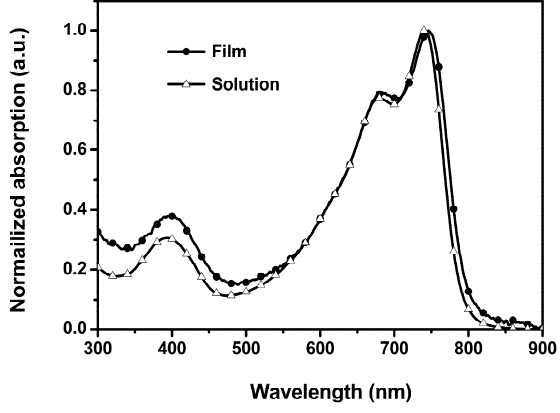
Figure 1. UV–vis absorption spectra of PSTDPP in 1 × 10 − 5 M chloroform solution and at solid state.